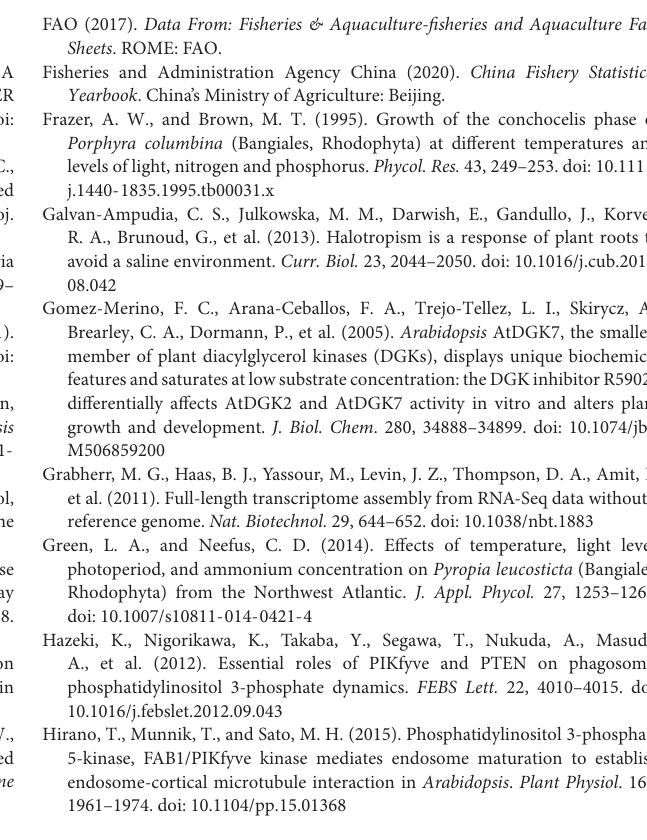
Supplementary Figure 2 | Eigengene expression profiles for yellow (A) and turquoise (B) modules. Bar-plot shows eigengene expression at each sampling point. For heat-maps, rows correspond to genes, columns correspond to samples, green denotes under-expressed genes, red denotes